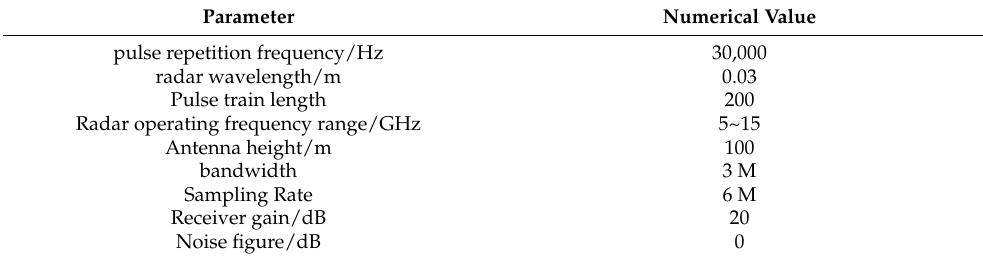
Table 2. Radar system